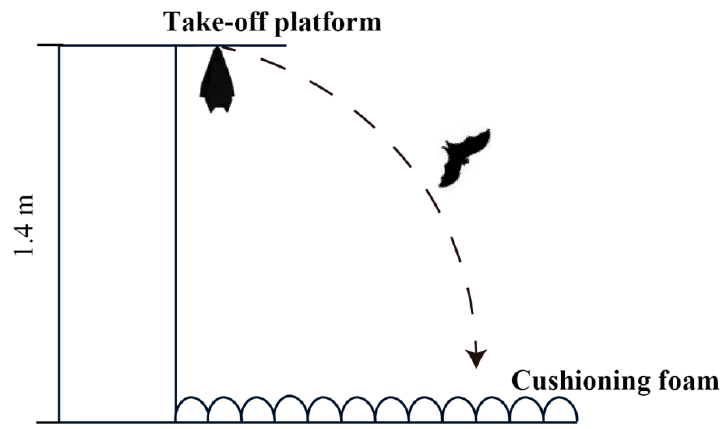
Figure 2. Schematic diagram of the flight experiment equipment.